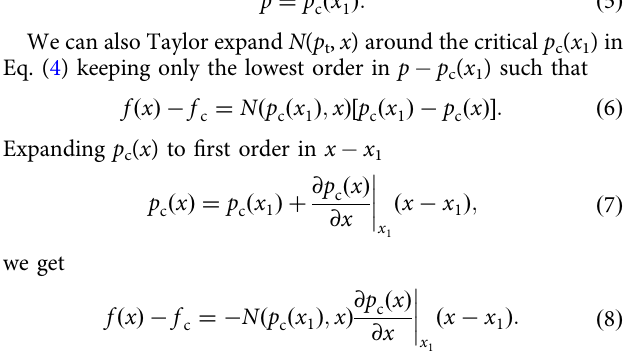
R ^ p c N ð ^ p t Þ d ^ p t (cid:5) 0 : 65. 0